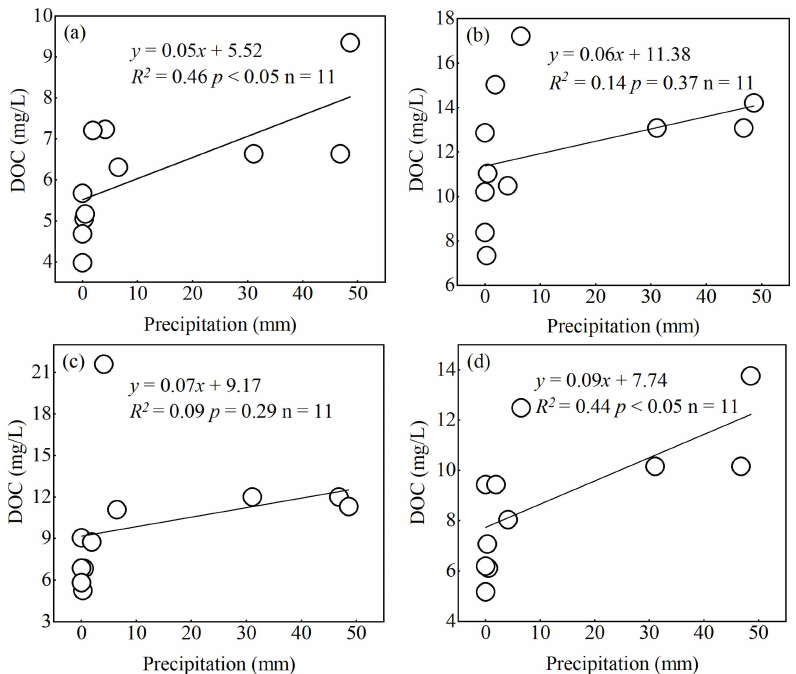
Figure 4. Temporal correlations between DOC concentration and precipitation in the natural pond ( a ), sewage pond ( b ), aquaculture pond ( c ), and irrigation pond ( d ). The 5-day accumulated precipitation (mm) before each sampling was used.